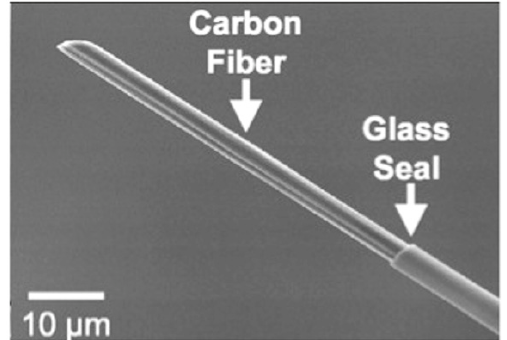
Figure 2: Scanning electron micrograph (SEM) image of a glass capillary insulated CFME (figures provided from Venton Lab). Figure comes from